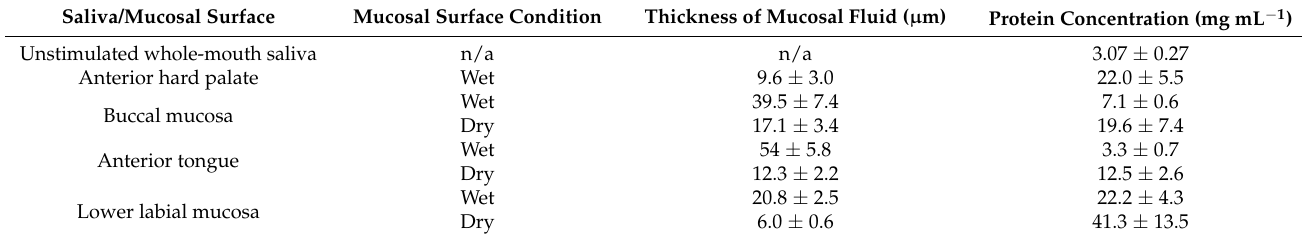
Table 1. Thickness and protein content of oral mucosa collected from the healthy volunteers (Reprinted with permission from Pramanik et al., 2010